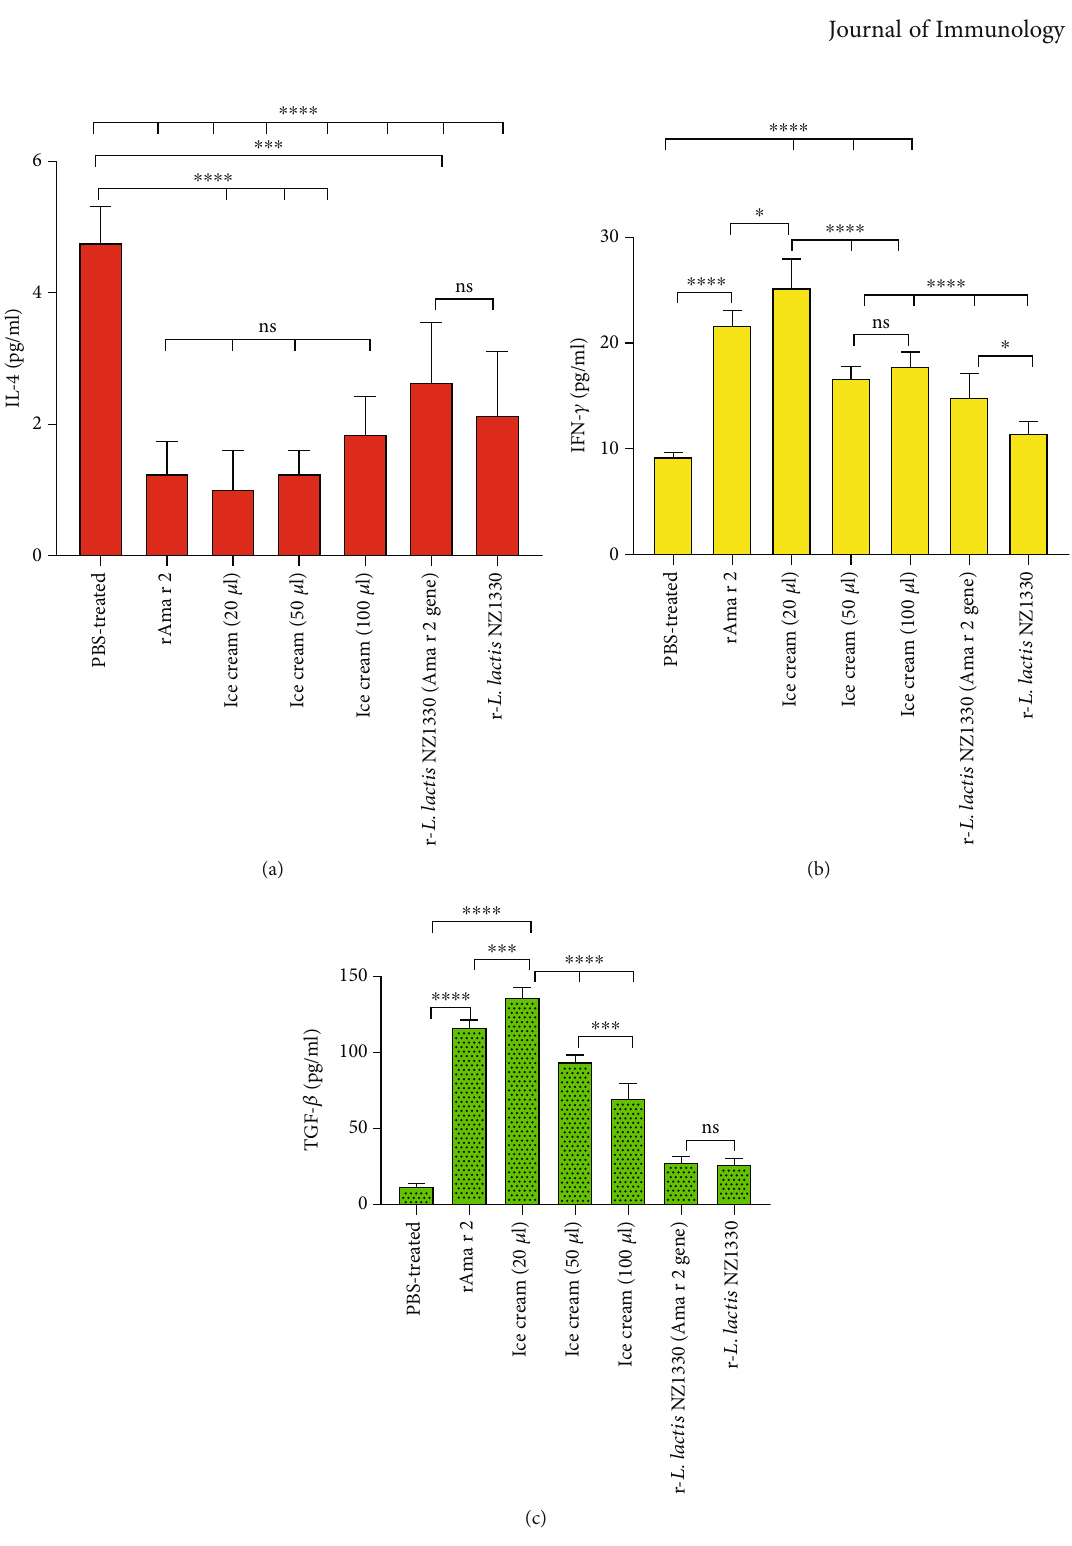
Figure 9: Cytokine levels IL-4 (a), IFN- γ (b), and TGF- β (c) in supernatant of spleen cell culture after the restimulation with rAma r 2. ns: not signi fi cant; ∗∗∗∗ p < 0 : 0001, ∗∗∗ p < 0 : 001 , ∗∗ p < 0 : 01 , and ∗ p < 0 : 05 versus the normal or PBS-treated group. Normal group: untreated and unsensitized group (PBS and alum-sensitive and treated with PBS), PBS-treated group: sensitized with Ama r 2 and PBS-treated, rAma r 2 group: sensitized with Ama r 2 and treated with pure rAma r 2 at a concentration of 40 μ g/ml, ice cream (20 μ l): sensitized with rAma r 2 and treated with 20 μ l ice cream containing r- L. lactis NZ1330, ice cream (50 μ l): sensitized with rAma r 2 and treated with 50 μ l of ice- cream containing probiotic bacteria, ice cream (100 μ l): sensitized with rAma r 2 and treated with 100 μ l of ice cream containing r- L. lactis NZ1330, r- L. lactis NZ1330 (Ama r 2 gene): sensitisize with Ama r 2 and treated with probiotic bacteria r- L. lactis NZ1330 which contains the Ama r 2, and r- L lactis NZ1330: sensitisized with Ama r 2 and treated with probiotic bacteria lacking the Ama r 2